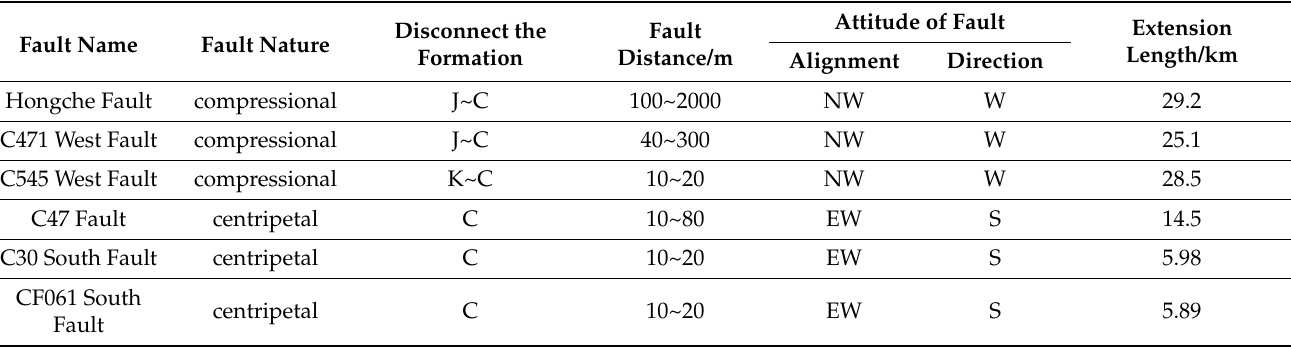
Table 2. Main fracture elements of Chepaizi